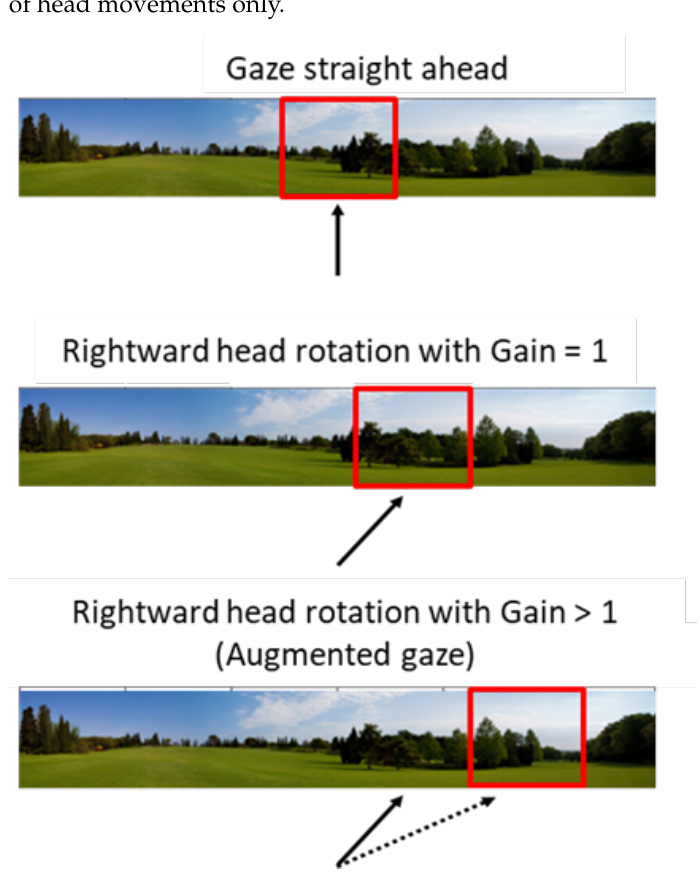
Figure 1. Augmented gaze. With the unitary gain, head movements and visual shifts are mapped 1:1 (i.e., the natural condition determined by head mechanics). When the visuomotor gain is higher, any given head movement produces a larger shift of the visual stimulus (visual amplification due to the augmented gaze condition). The red frame represents a hypothetical central region of the visual field, the solid arrow indicates the current head direction, and the dotted arrow represents the (larger) head movement that would have been required to produce that visual shift. Eye movements were not considered in this study; thus, the term augmented gaze refers to the visual amplification of head movements